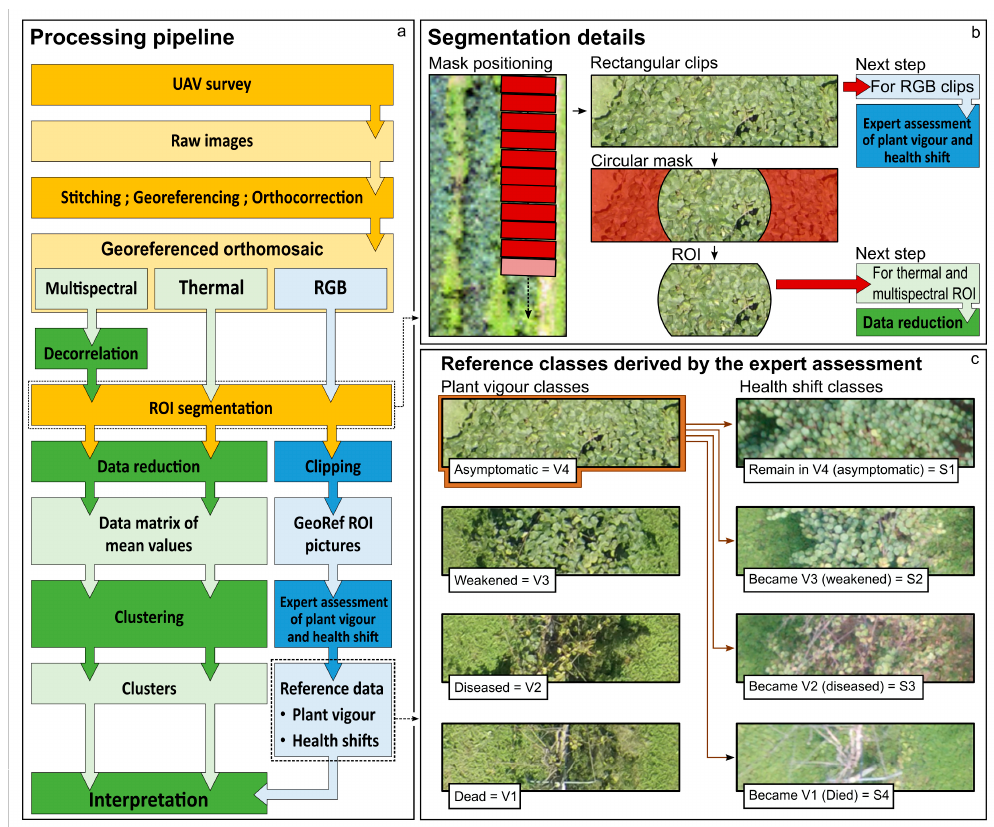
Figure 1. Overall processing pipeline. In ( a ) processes are represented with a darker background, while data have a light background. The green steps represent data and processes, used for the unsupervised classification of multispectral and thermal data; the blue steps represent factors used for reference data estimation based on RGB clips; the yellow steps are common between the two processing pipelines. In ( b ) details of the segmentation process are depicted: starting with mask positioning along planting lines, proceeding with rectangular shape clipping and concluding with circular mask extraction. In ( c ) the classes derived by the expert assessment are shown for each vigour and plant health shift class. On the left, the four vigour classes are represented from highly vigorous and asymptomatic (V4) to dead (V1). On the right, the classification of the health shifts that occurred between 2017 and 2018 in plants that were initially highly vigorous and asymptomatic (V4) is reported: from those that remain highly vigorous and asymptomatic in the second year (S1), to the ones that in 2018 were weakened (S2), diseased (S3) or dead (S4). Abbreviations: ROI, region of interest; GeoRef, georeferenced.